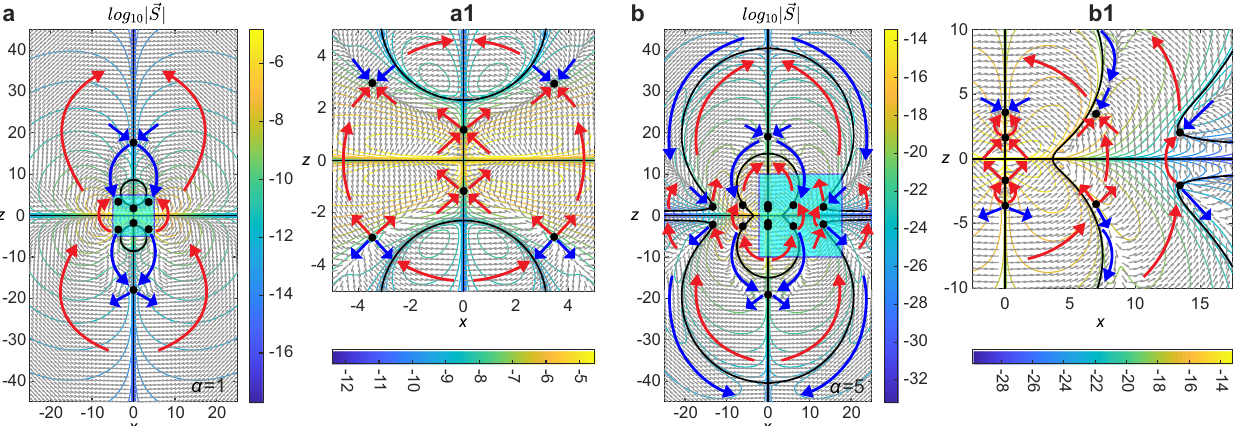
Fig. 4 Poynting vector fi elds of toroidal and supertoroidal light pulses. a , b Contour and arrow plots of the Poynting vector fi elds in the x – z plane, in logarithmic scale, for a ) the fundamental TLP and b the STLP of α = 5. Panels a1 and b1 present the zoom-in plots of the regions of blue boxes in ( a ) and ( b ), respectively. Poynting vector fi eld zeros are marked by the black solid lines and black dots. Red and blue bold arrows highlight the regions of energy forward fl ow and back fl ow, respectively. Unit for coordinates: q 1